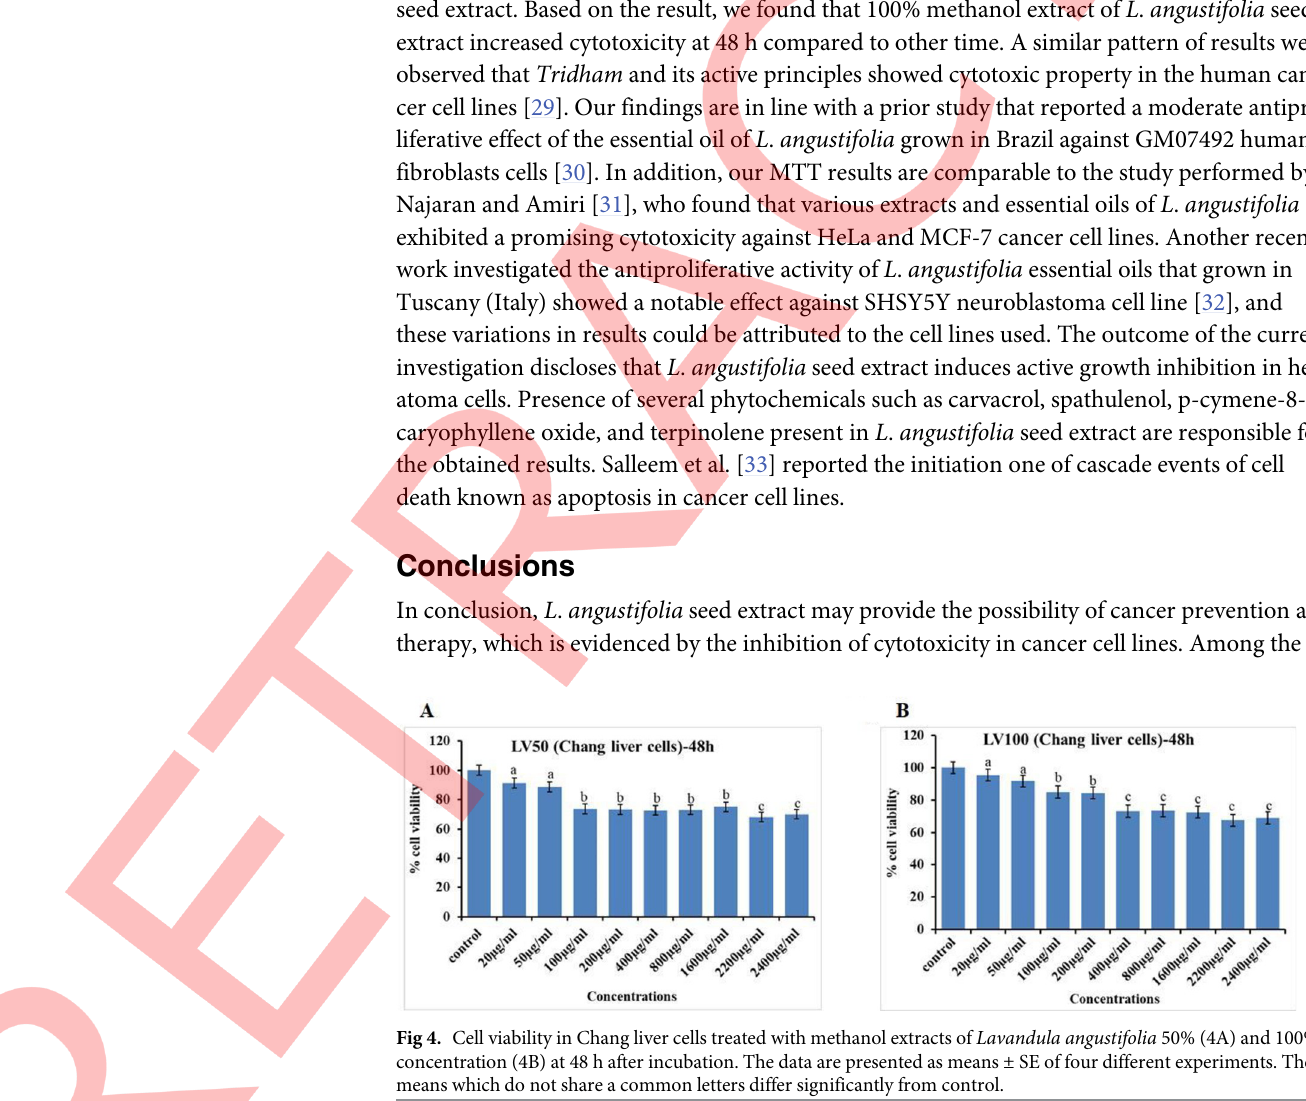
Fig 4. Cell viability in Chang liver cells treated with methanol extracts of Lavandula angustifolia 50% (4A) and 100% concentration (4B) at 48 h after incubation. The data are presented as means ± SE of four different experiments. The means which do not share a common letters differ significantly from